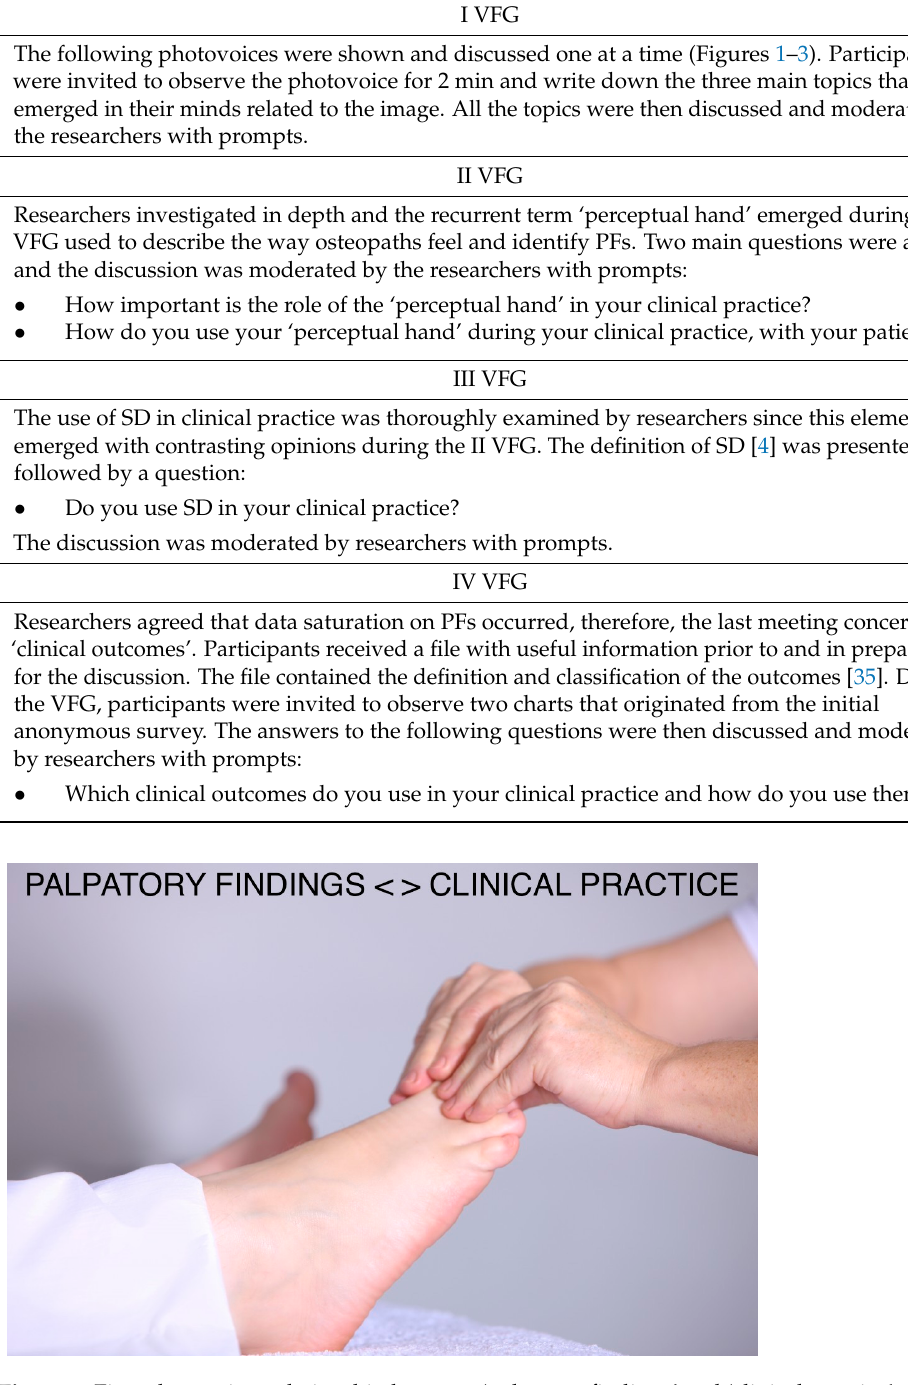
Figure 1. First photovoice: relationship between ‘palpatory findings’ and ‘clinical practice’.